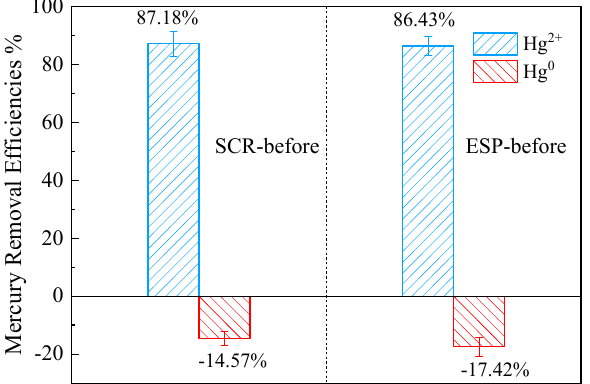
Figure 11. Removal efficiency of Hg 0 and Hg 2+ in the WFGD device.